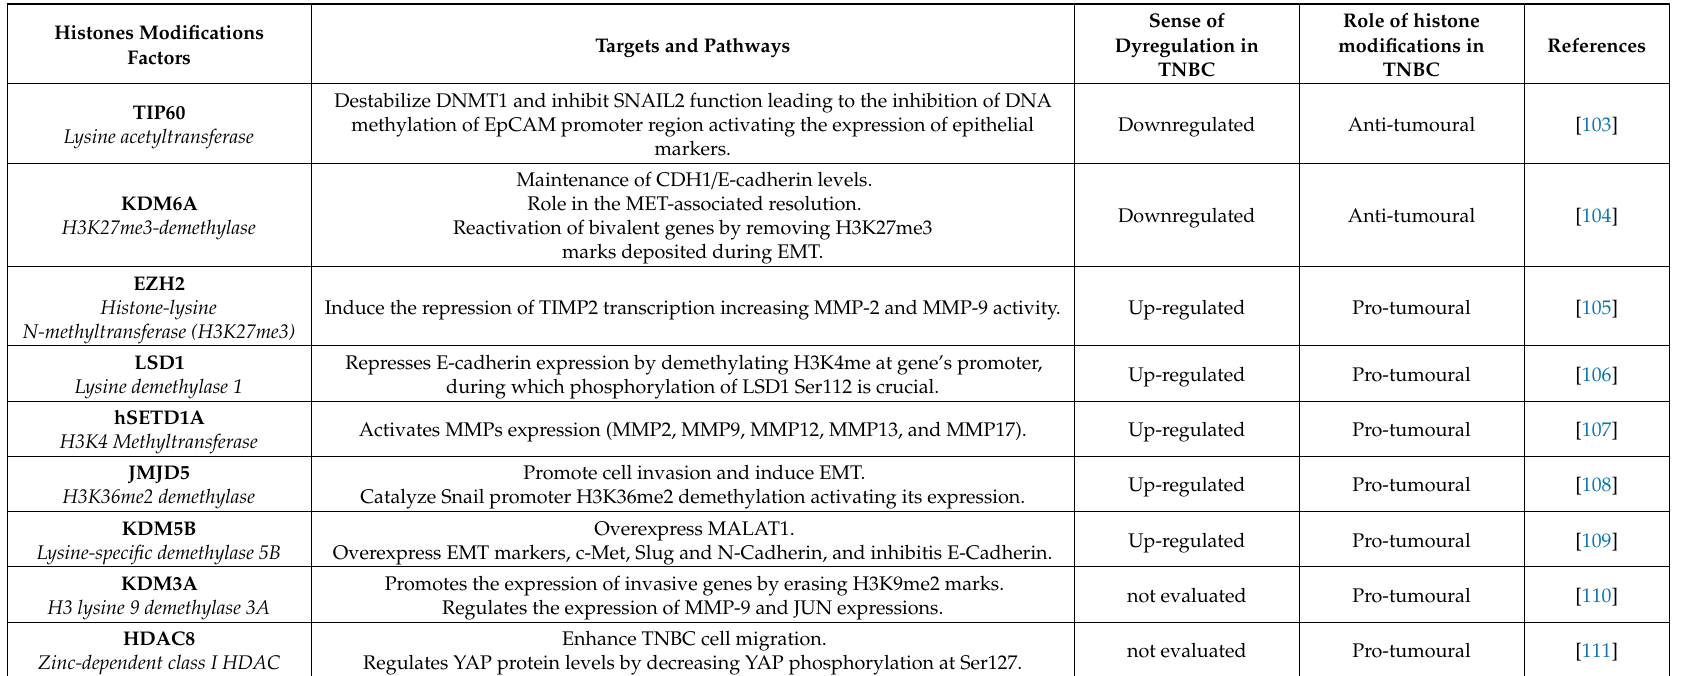
Table 3. Histone modification factors associated with EMT of